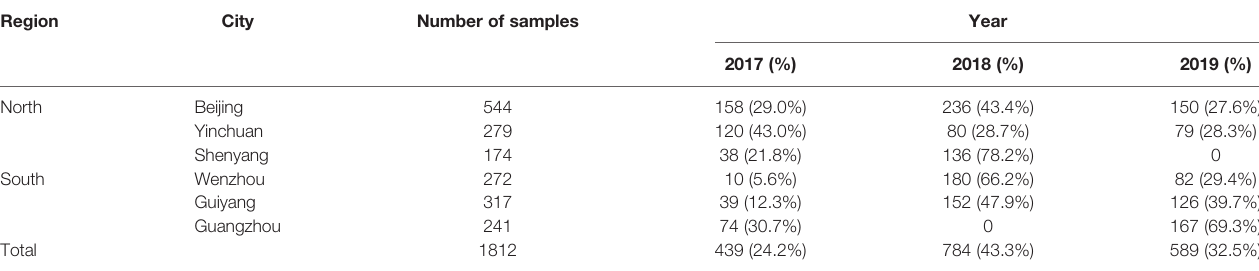
TABLE 3 | Specimen collection time and regions of the multicentre study. Region